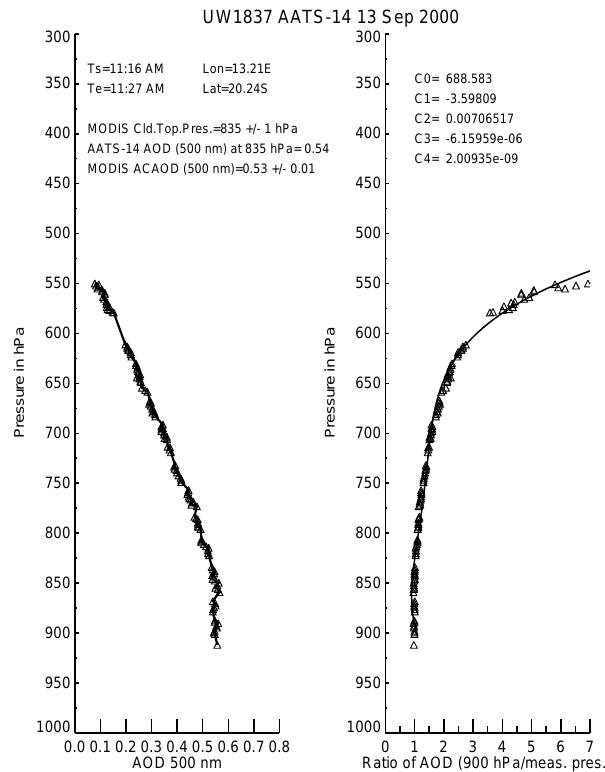
Figure 1. Left: vertical profile of above-aircraft columnar AOD (500nm) measured by AATS-14 during SAFARI-2000 flight UW1837, which flew on 13 September 2000 over Walvis Bay. Right: altitude dependence of ratio of AOD at 900hPa to AOD at different pressure levels measured during the same